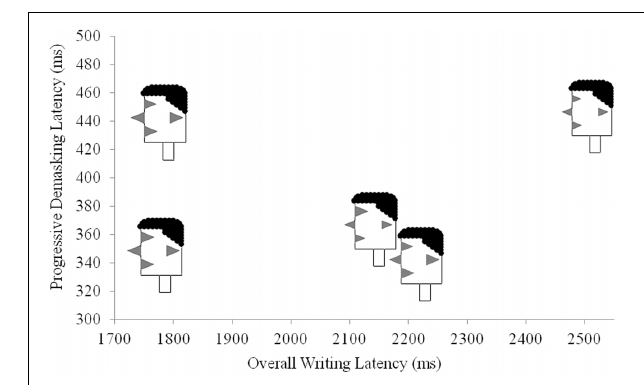
FIGURE 9 | Participant profiles used to replace participant data points on a